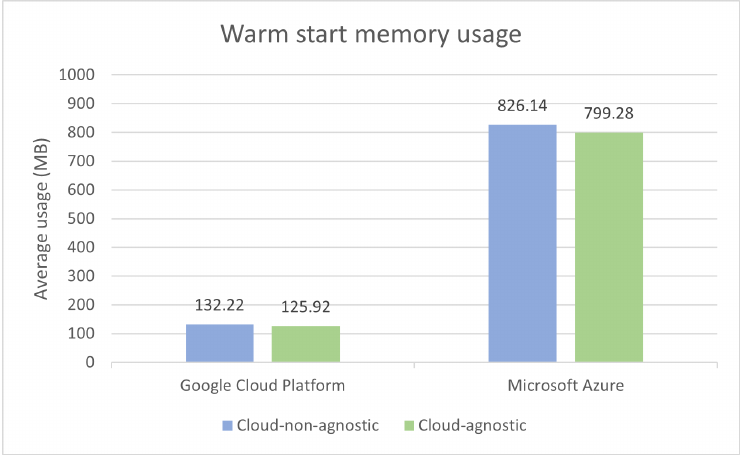
Figure 16. Warm start memory